Question: Condense the content of this figure into a single sentence.
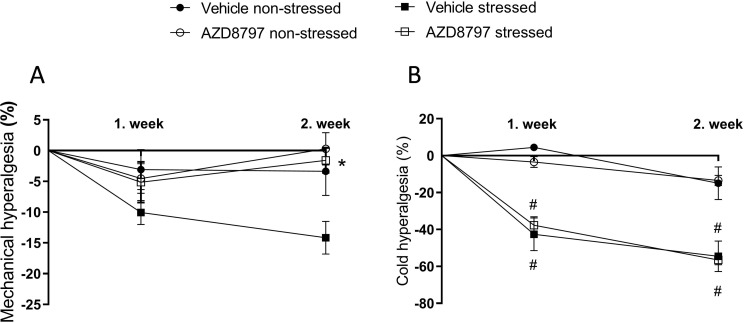
Answer: Effects of chronic restraint stress (CRS) on nociceptive behaviors of wild-type (WT) and CX3CR1 knock-out (KO) male mice. Mechanonociceptive threshold (A) and cold tolerance [paw withdrawal latency, (B) ] changes are presented compared to the baseline threshold. Data are presented as the mean ± SEM (n= 7–11); two-way repeated measurement analysis of variance (ANOVA), followed by Sidak’s tests; *p<0.05 vs. respective vehicle-treated group; # p<0.0001 vs. respective non-stressed groups.